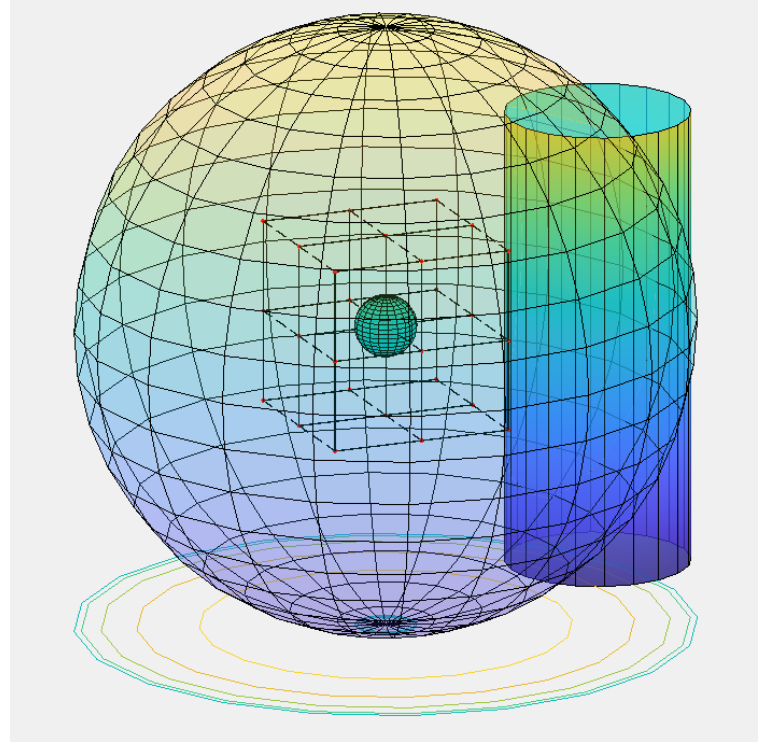
Figure 5. When the UAV detects an obstacle.